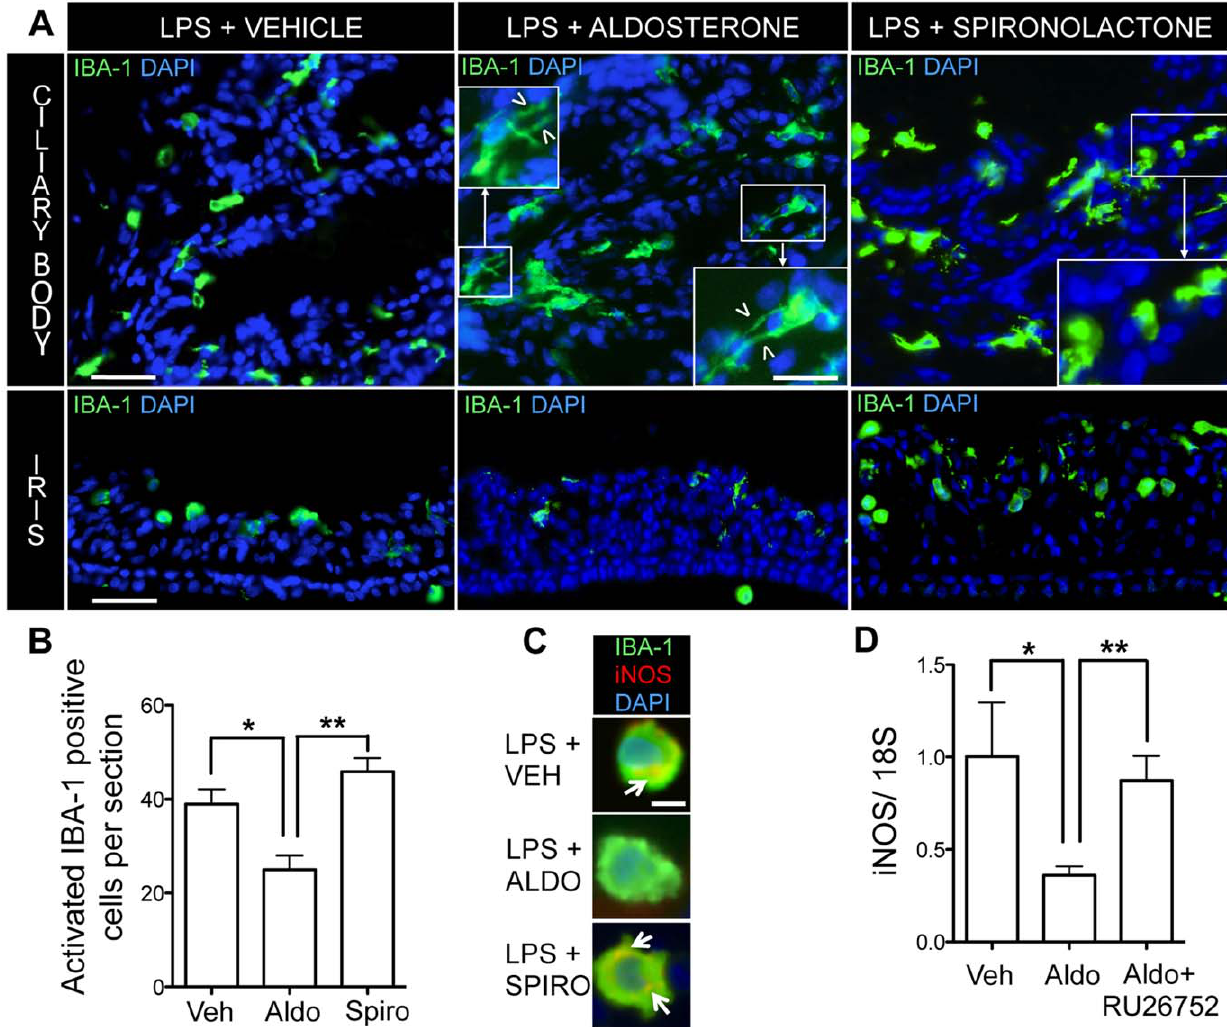
Figure 4. Aldosterone reduces activation of microglia/macrophages in EIU. A: Immunofluorescence detection of IBA-1 microglia/ macrophages on sections of inflamed eyes injected with vehicle, aldosterone or spironolactone. Twenty-four hours after LPS injection, in vehicle and spironolactone-injected eyes, many microglial cells had a round amoeboid shape attesting for their activation in the iris/ciliary body. By contrast, in aldosterone-injected eyes, more microglial cells had a resting dendritic shape with long branchings (white arrowheads). Merge images of IBA-1 (green) and DAPI (blue); scale bar: ciliary body: 40 m m; 25 m m for insert; iris: 60 m m. B: Quantification of activated IBA-1 microglia/macrophages on sections of inflamed eyes that were injected with vehicle, aldosterone or spironolactone. Twenty-four hours after LPS injection, less number of round activated IBA-1 positive cells was found in eyes sections with injection of aldosterone (Aldo) vs vehicle (Veh) or spironolactone (Spiro). Data are expressed as means 6 SEM of 2 sections/rat; n=4 rats per condition; *p , 0.05, **p , 0.01. C: Immunofluorescence of iNOS on sections of inflamed eyes injected with vehicle, aldosterone or spironolactone. Twenty-four hours after LPS injection, few round IBA-1 positive macrophages/microglia expressed iNOS in vehicle and spironolactone-injected eyes (colocalization: yellow, arrow). By contrast, iNOS signal was reduced in IBA-1 positive macrophages/microglia in aldosterone-treated eyes. Merge image of IBA-1 (green), iNOS (red) and DAPI (blue); scale bar: 10 m m; n=4 rats per condition. D: iNOS mRNA expression (real-time PCR) in cells infiltrating the aqueous humor in EIU. In EIU, inflammatory cells (neutrophils and macrophages) accumulate in aqueous humor. In cells collected in aqueous humor from EIU eyes, iNOS mRNA expression was significantly reduced by aldosterone (Aldo) IVT compared to vehicle (Veh) IVT. This effect was prevented by the co-administration of aldosterone with the MR antagonist RU26752. The 18S was used as housekeeping gene. Results are relative changes compared to vehicle-injected eyes. Data are means 6 SEM; n=4–5 rats per condition; *p , 0.05.